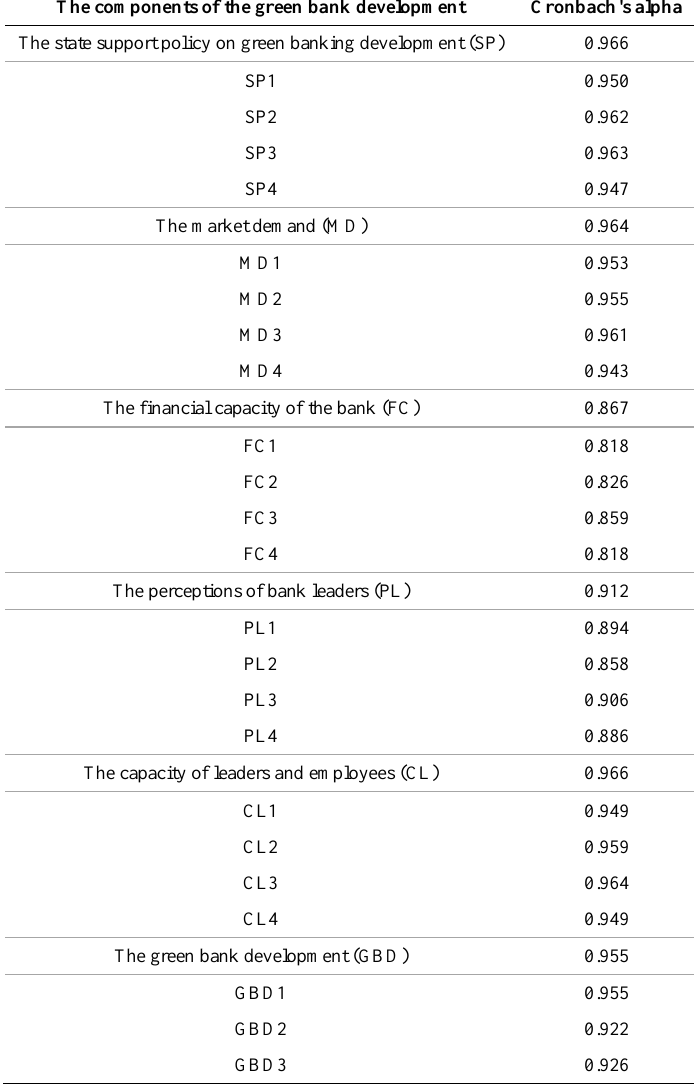
Table 2. Testing of Cronbach's alpha for five factors affecting the green bank